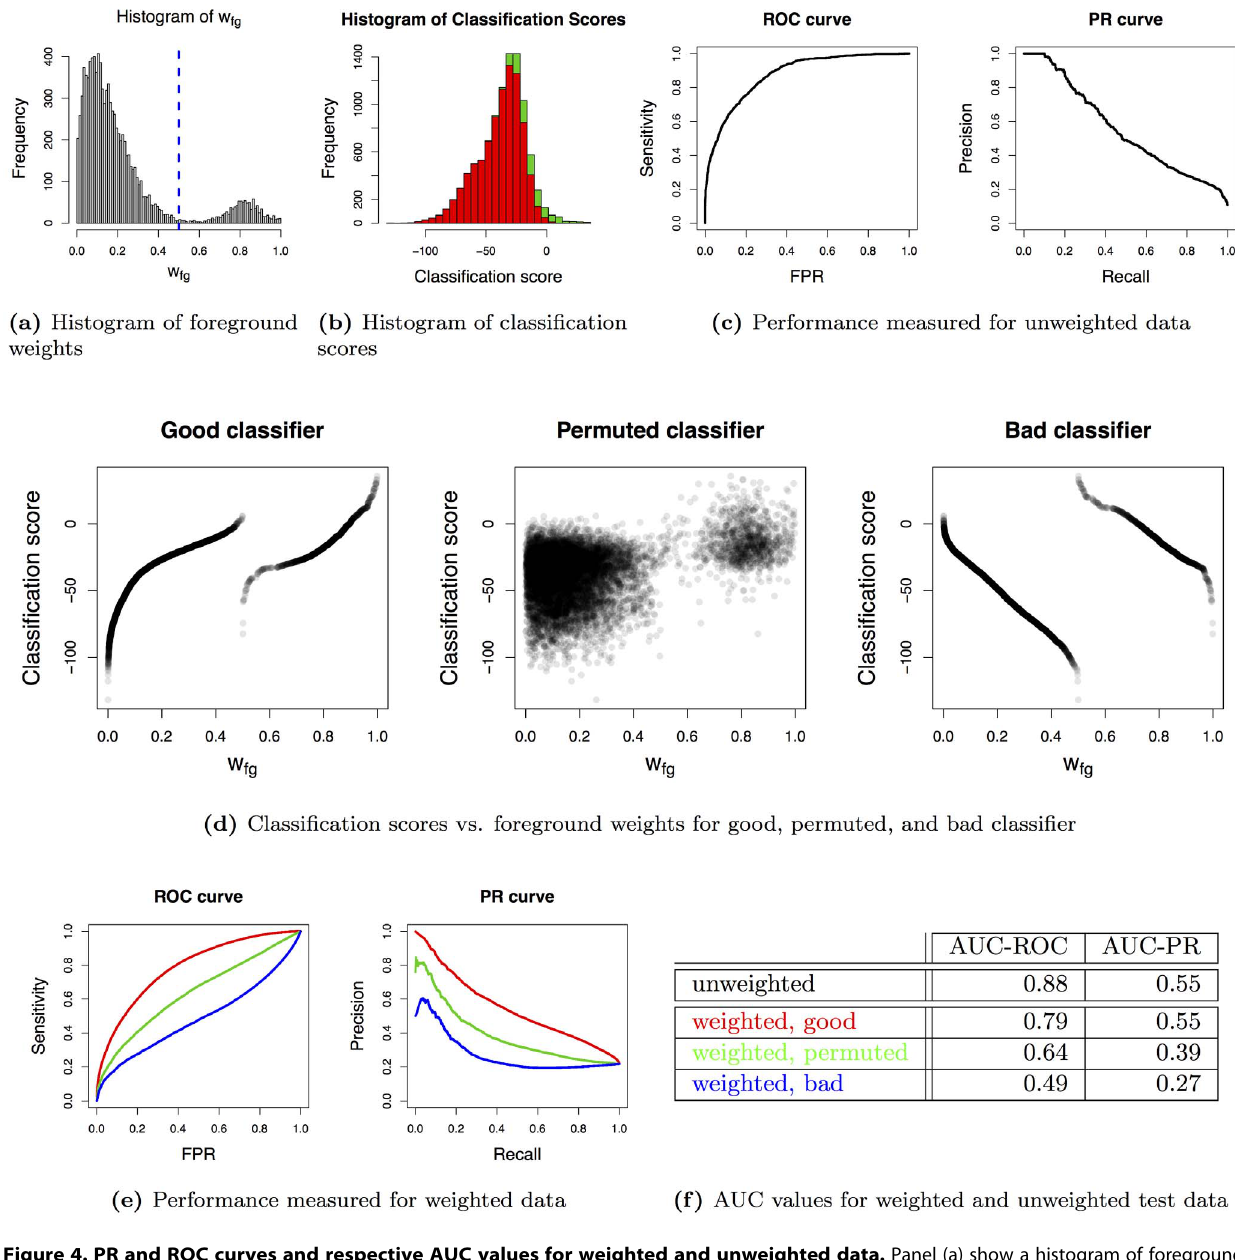
Figure 4. PR and ROC curves and respective AUC values for weighted and unweighted data. Panel (a) show a histogram of foreground weights ( w fg , n ) for all data points. The dashed line indicates the threshold used to separate foreground and background data points in the unweighted case. Panel (b) presents a histogram of classification scores. Within the bars of the histogram, we visualize the number of data points from the foreground (green) and background (red) class according to the unweighted case. Panel (c) presents classification performance using unweighted data computed from the classification scores presented in panel (b). Panel (d) visualizes the relationship between classification scores and weights for the hypothetical good, permuted, and bad classifiers. All three orderings of classification scores share the same underlying distribution as shown in panel (b). Panel (e) show the clearly distinguishable classification performance of the three classifiers as measured by ROC and PR curves using weighted data. The corresponding AUC values are listed in panel